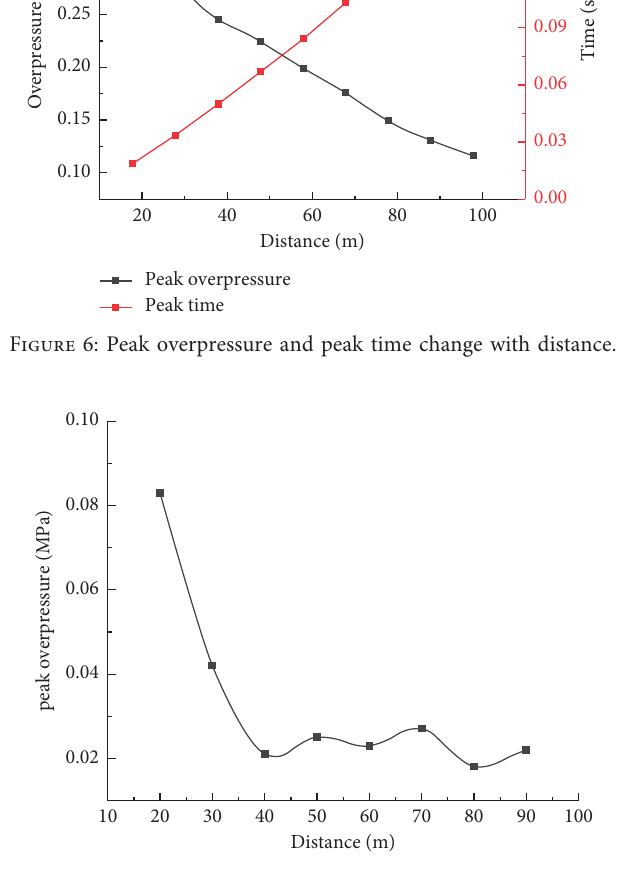
Figure 7: Overpressure difference between adjacent measuring